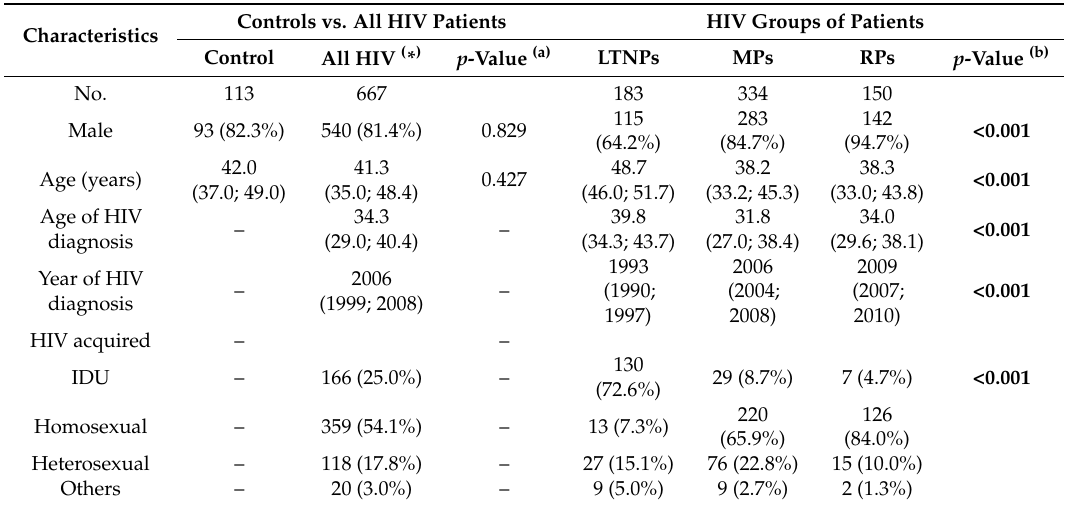
Table 1. Clinical and epidemiological characteristics of HIV infected patients and healthy donors. Characteristics